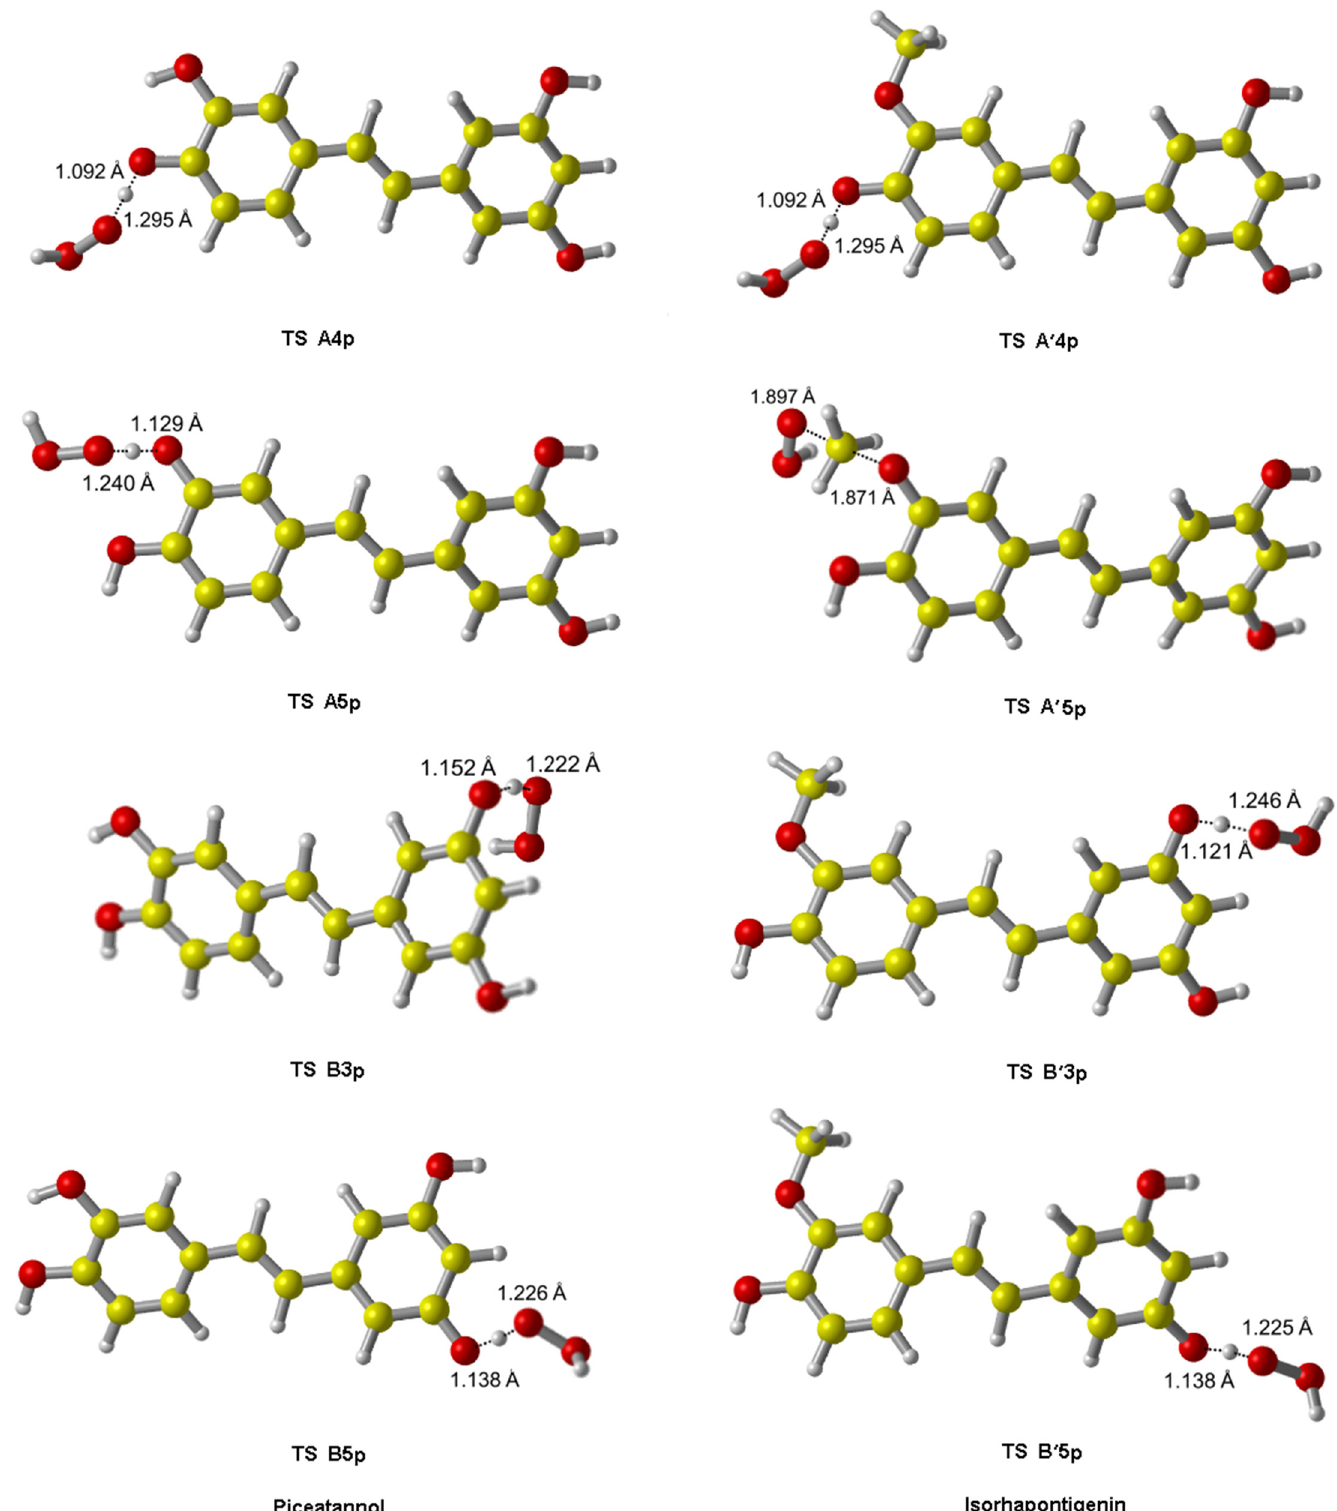
Fig 7. The transition state geometries of PIC and ISO from ABS reaction initiated by (cid:129) OOH. For the same active site of PIC and ISO, the corresponding TS structures are very similar.